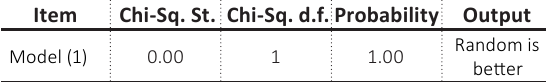
Table 8. Hausman test results